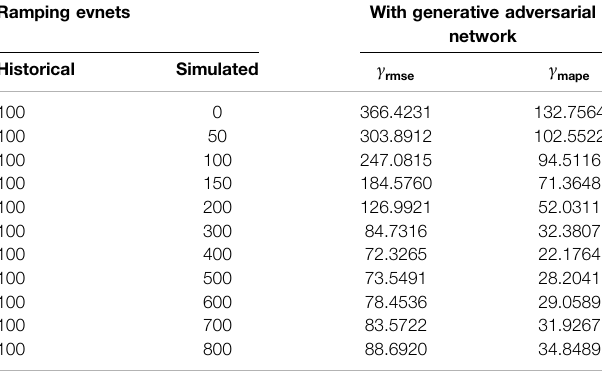
TABLE 3 | Prediction effect of different proportions of simulated data.